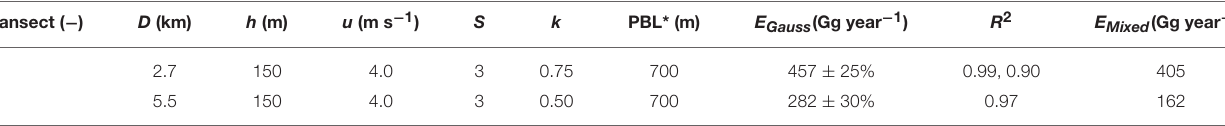
TABLE 1 | Best scenario estimated flux and parameters. Transect ( −